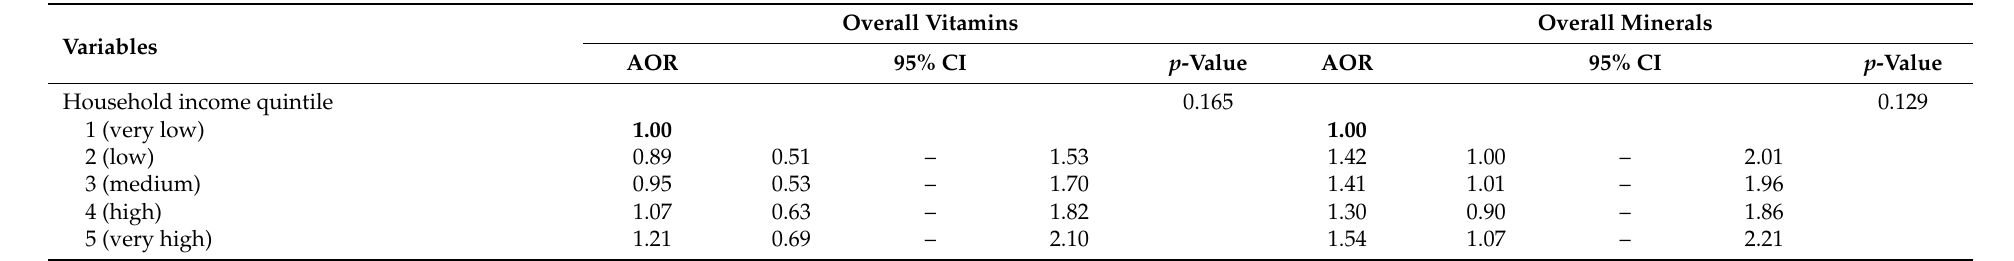
Table 2. Logistic regression analysis of factors related to vitamin, mineral intake. The groups at the top of each criterion were compared with each of the